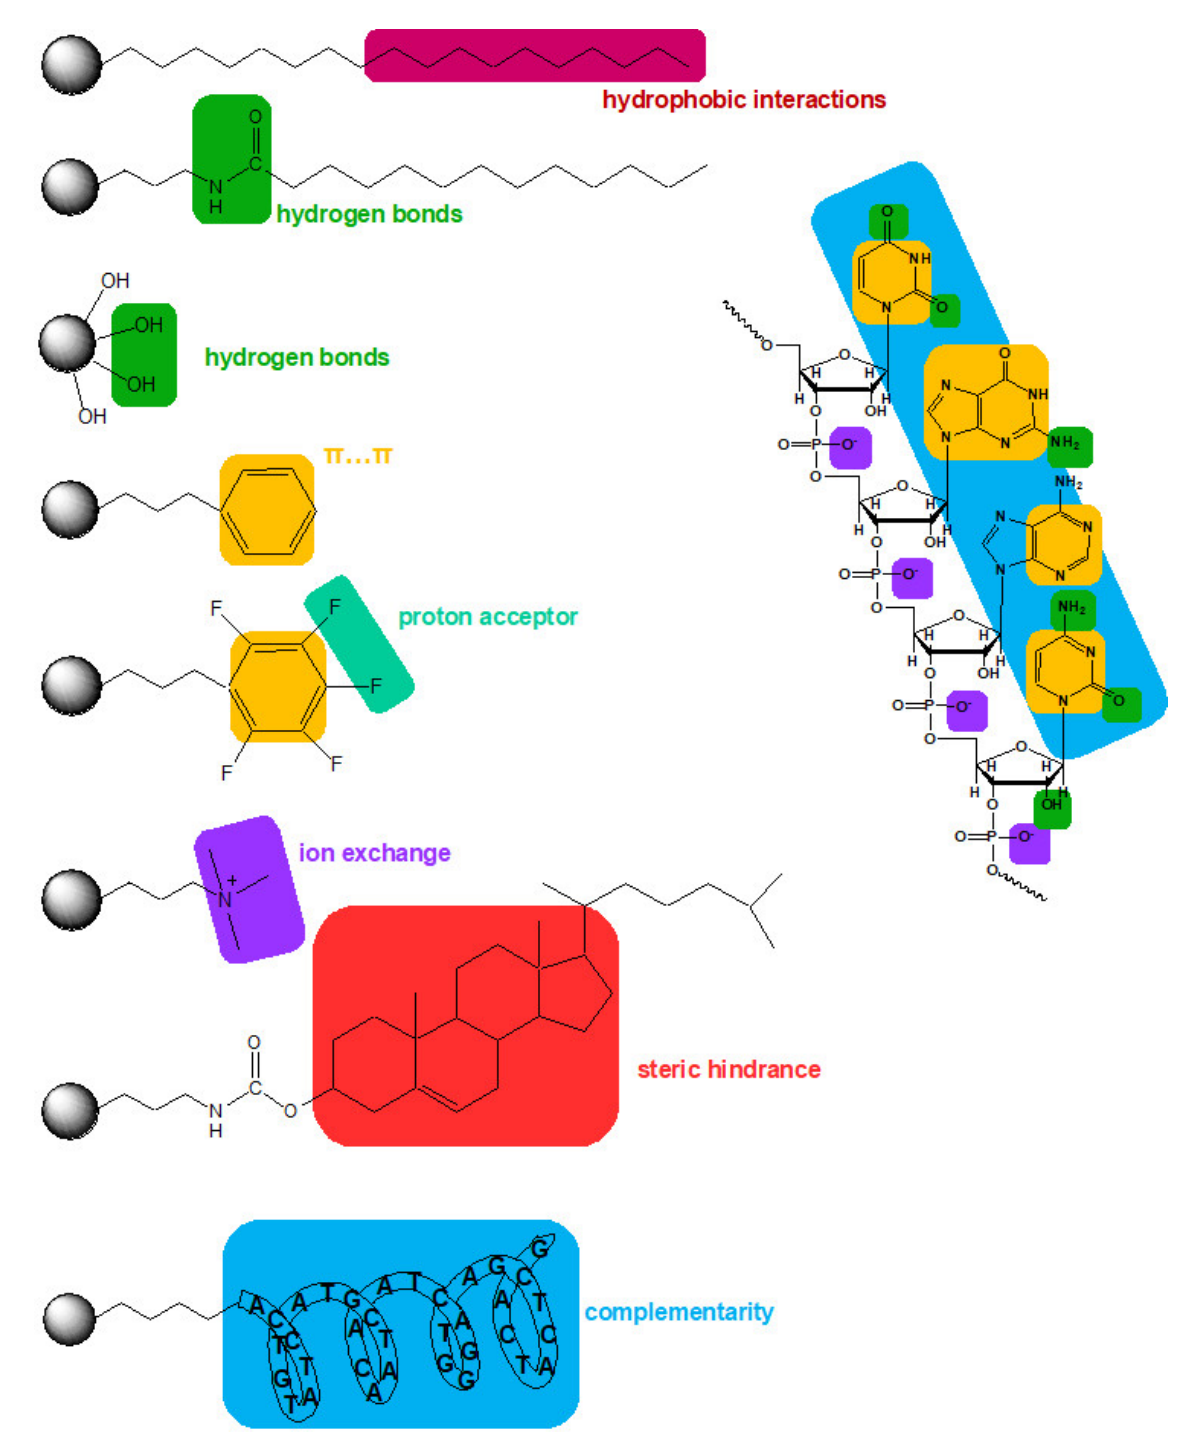
Figure 4. Schematic representation of possible interactions between the oligonucleotide and some stationary